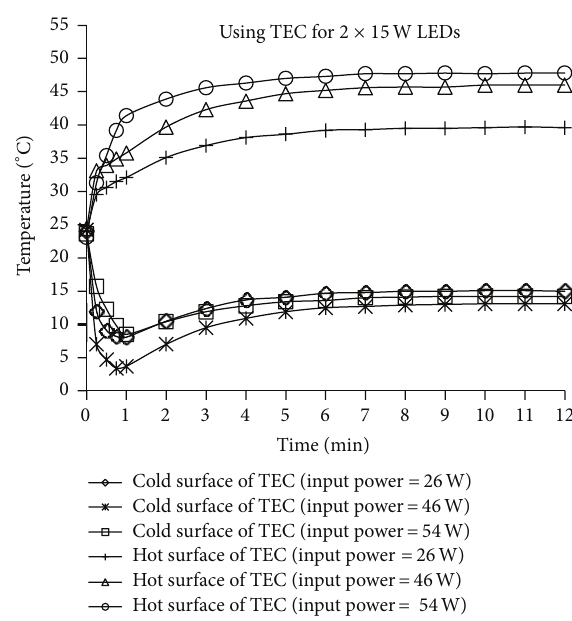
Figure 10: The cold and hot surface temperature values of the TEC element during the cooling process of the LEDs the 2 × 15 W LEDs configuration via cooling systems in which the TEC elements were used.